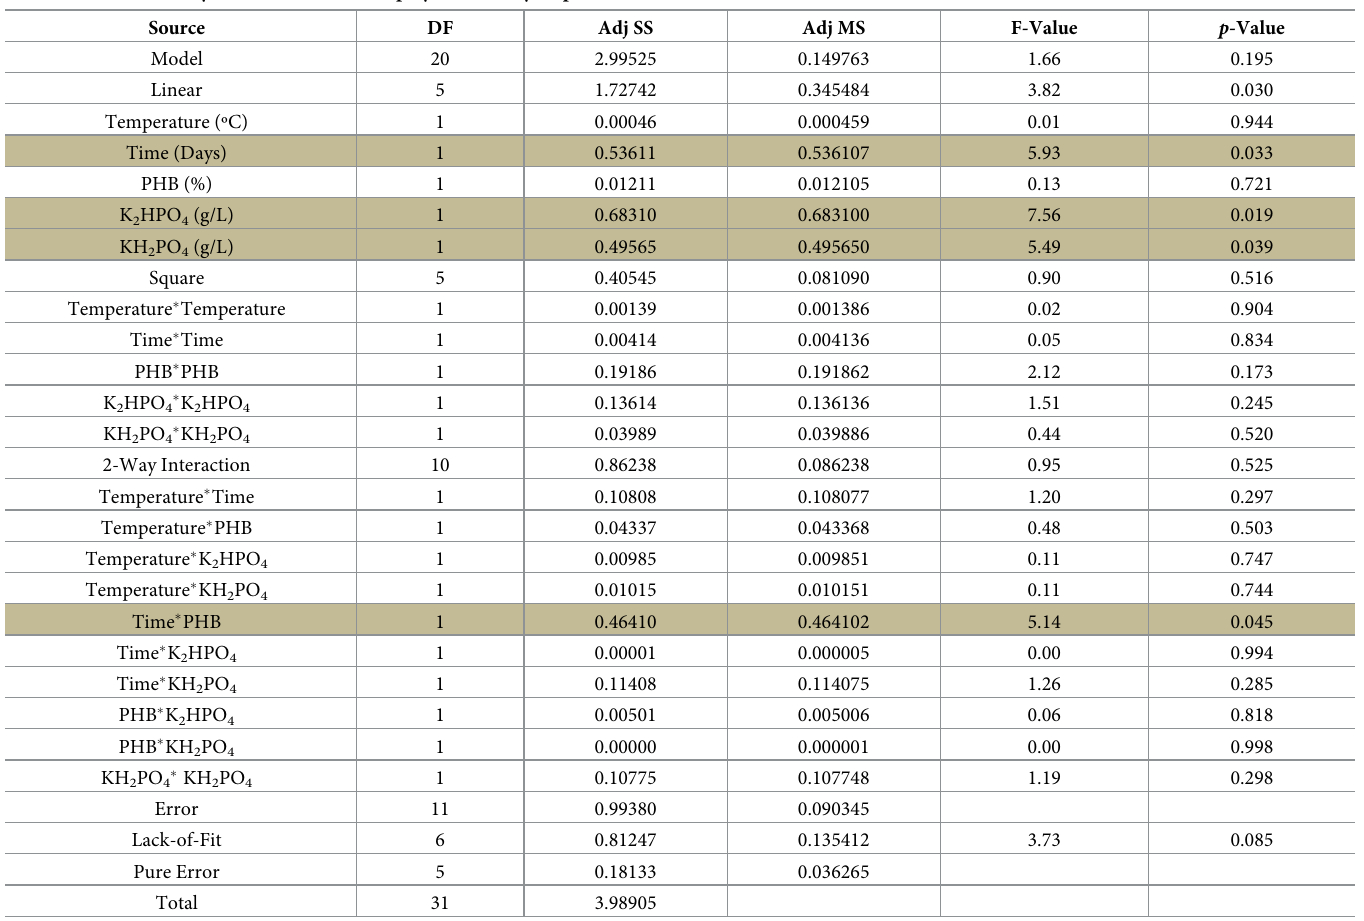
Table 11. ANOVA analysis of CCD for PHB depolymerase enzyme